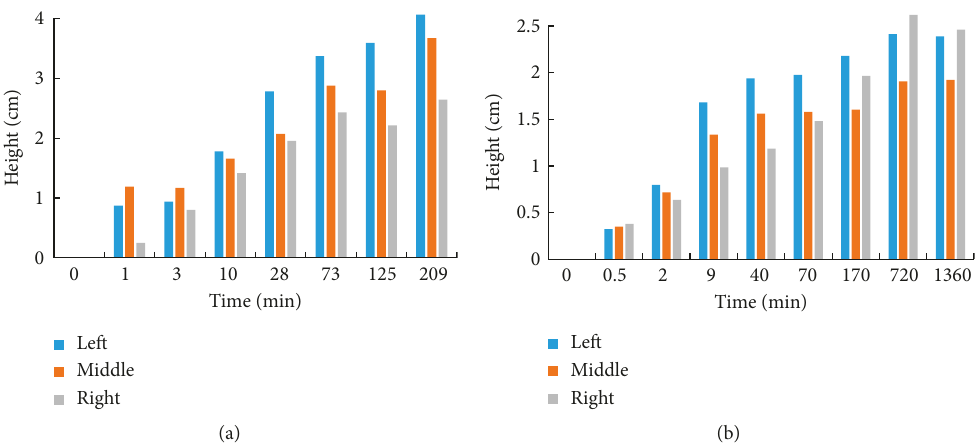
Figure 11: Height of intruded line over time. (a) 3# sample is under free restraints. (b) 1# sample is under lateral restraints.